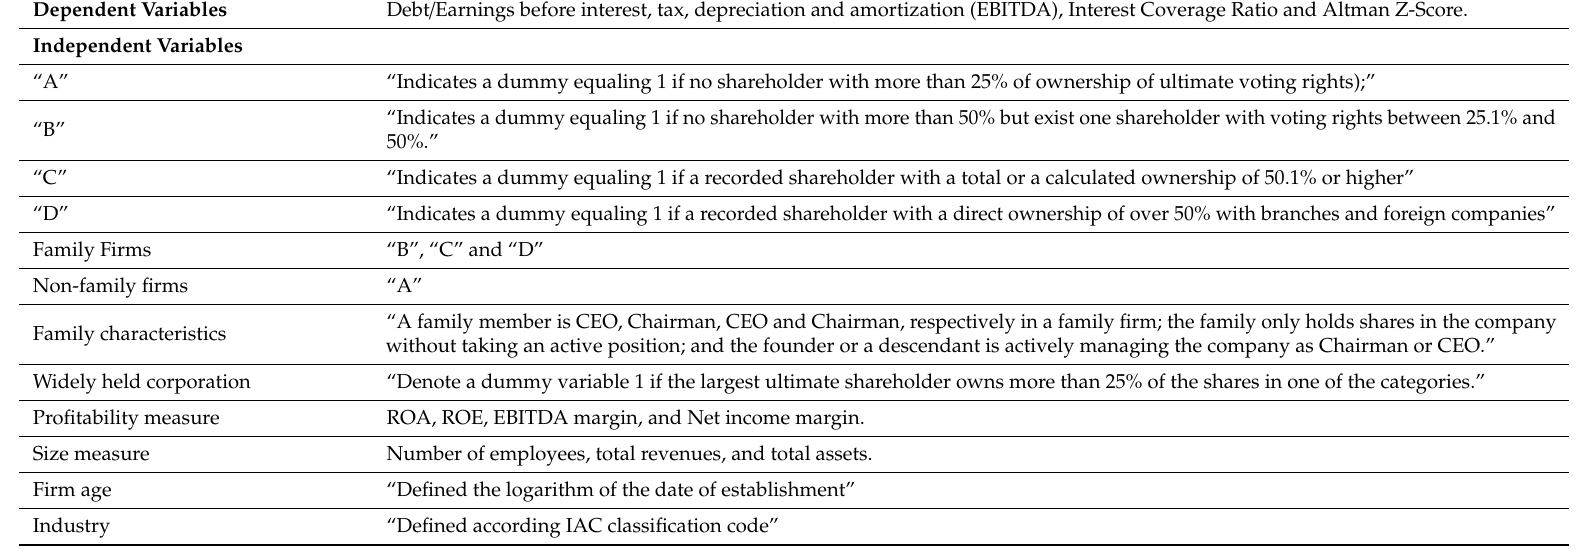
Table 1. Definition of